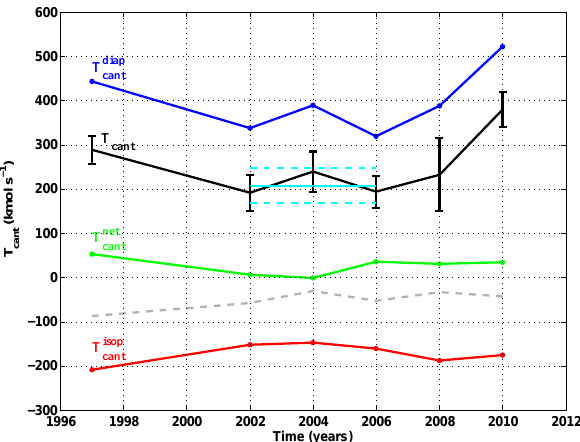
Fig. 3. T cant (black) and its components (blue, red and green) across the OVIDE section as a function of time. The dashed grey line is the transport of Cant due to the Ekman transport; this component is dis- patched between the other three components. The cyan lines are the mean value (2002–2006) and the error bars of T cant representative of the